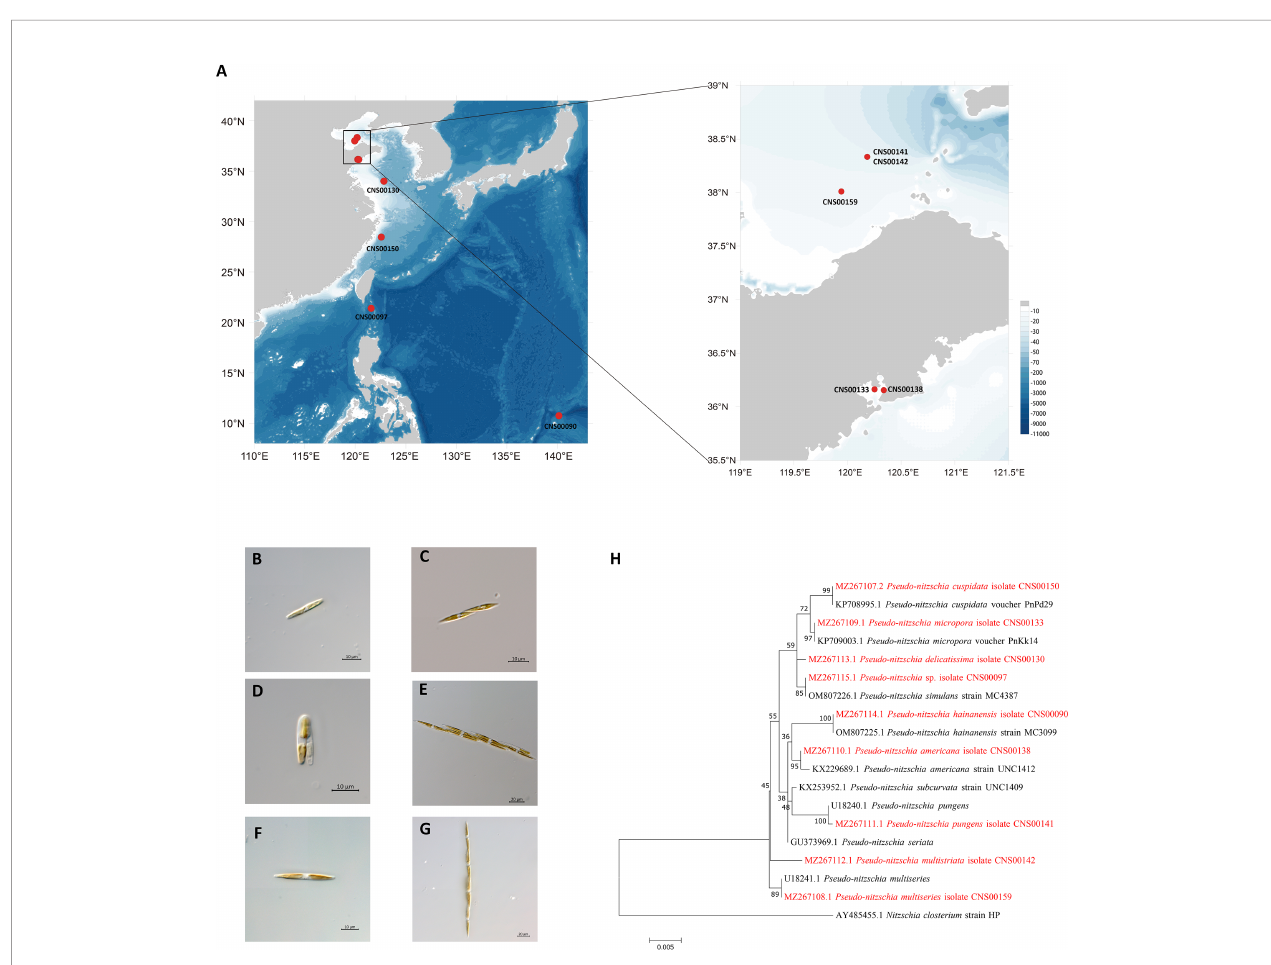
FIGURE 1 | Collection localities of nine Pseudo-nitzschia strains (A) . Micrographs of Pseudo-nitzschia sp. CNS00097 (B) , P. delicatissima CNS00130 (C) , P. americana CNS00138 (D) , P. pungens CNS00141 (E) , P. multistriata CNS00142 (F) , and P. multiseries CNS00159 (G) . Phylogenetic analysis based on 18S ribosomal DNA (18S rDNA) gene (H) . Numbers at the branches represent bootstrap values. Branch lengths are proportional to the genetic distances, which are indicated by the scale